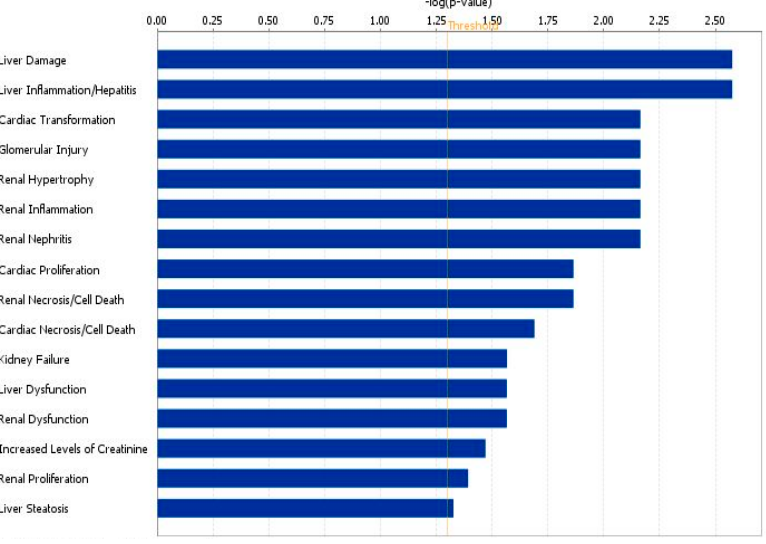
Figure 4. Biological processes most differentially modulated in ccRCC patients generated from urinary metabolites obtained through variable size bucketing.